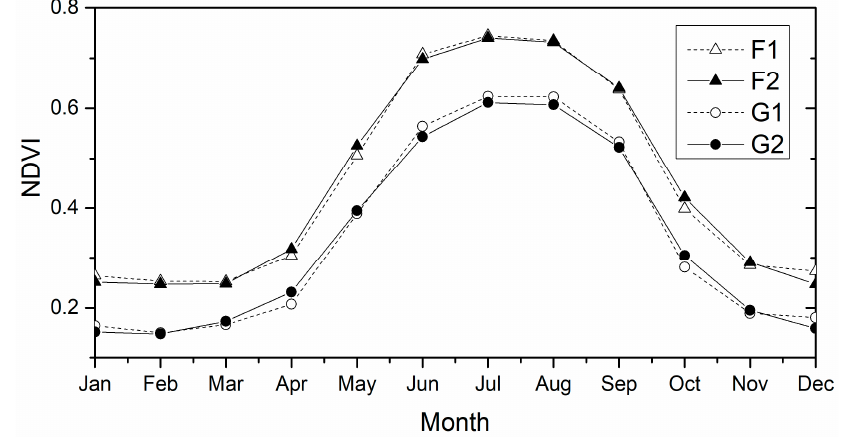
Figure 7. Annual NDVI time series for forest and grassland from 1982–1999 and 2000–2015. F1: forest